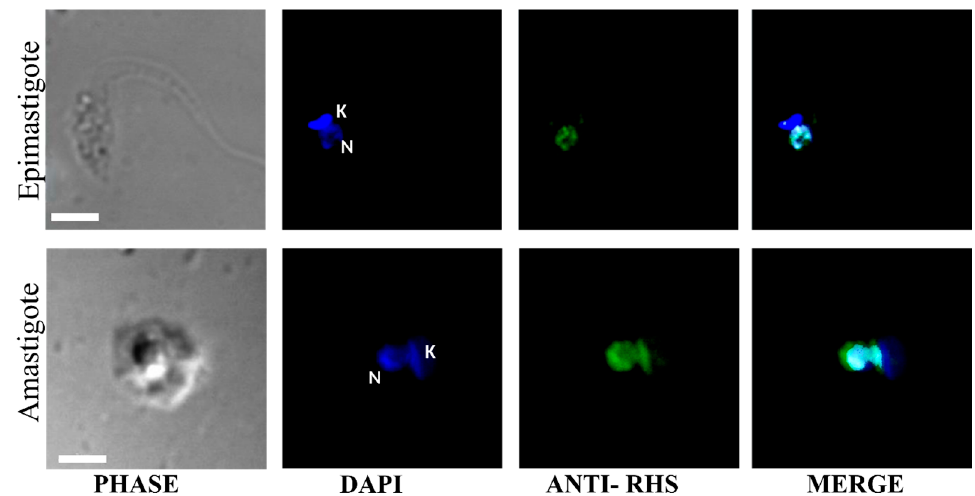
Figure 6. Cellular localization of RHS in the amastigote of T. cruzi. Confocal microscopy images from indirect immunofluorescence reaction with anti-RHS antibodies (diluted 1:1000) in permeabilized epimastigotes and amastigotes of clone CLB. The labeling of the nucleus and kinetoplast DNA (DAPI) and RHS proteins is shown in blue and green, respectively. Scale bar 3 μ m . N, nucleus; K, kinetoplast.